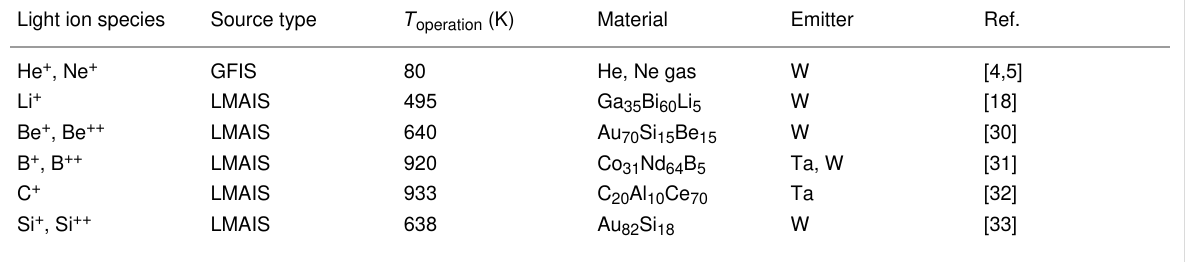
Table 1: Light ion species, source type, source temperature for GFIS and LMAIS, source material, emitter tip material, and corresponding references. For the LMAIS, the listed temperatures are the melting points of the eutectic alloy. The actually used temperatures are a little higher.